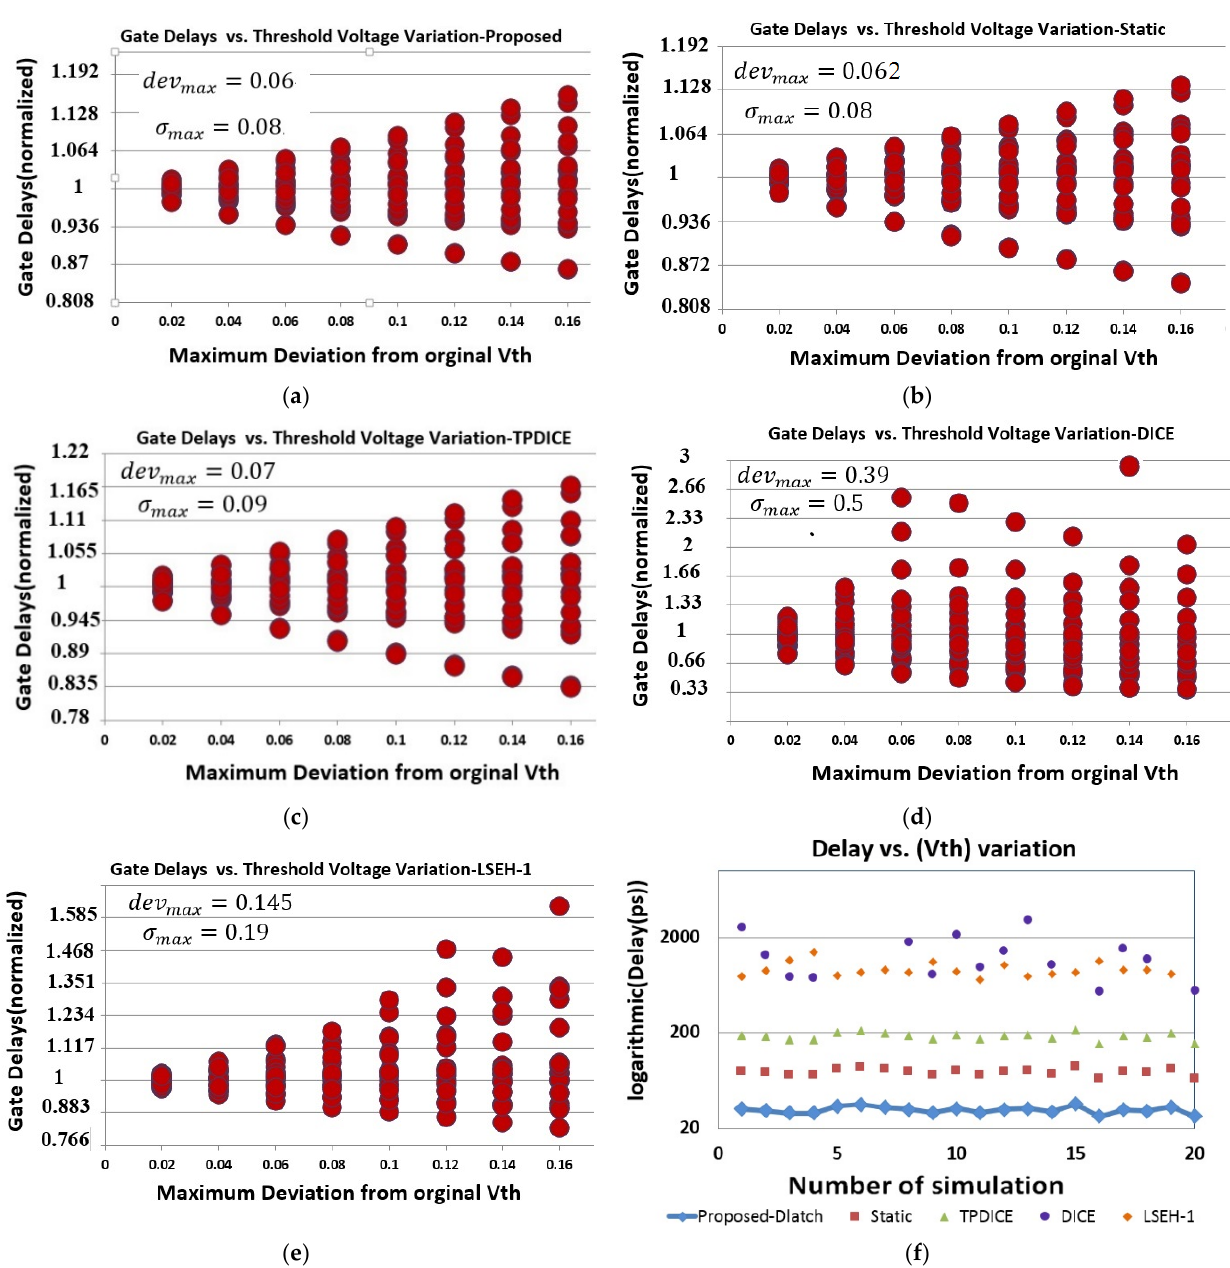
Figure 13. Threshold voltage variation effect on D-latch delay: ( a ) proposed D-latch ( b ) Static D-latch ( c ) TPDICE-based D-latch ( d ) DICE ( e ) LSEH-1 latch ( f ) delay of D-latches with maximum deviation, 0.16, from original threshold voltage.